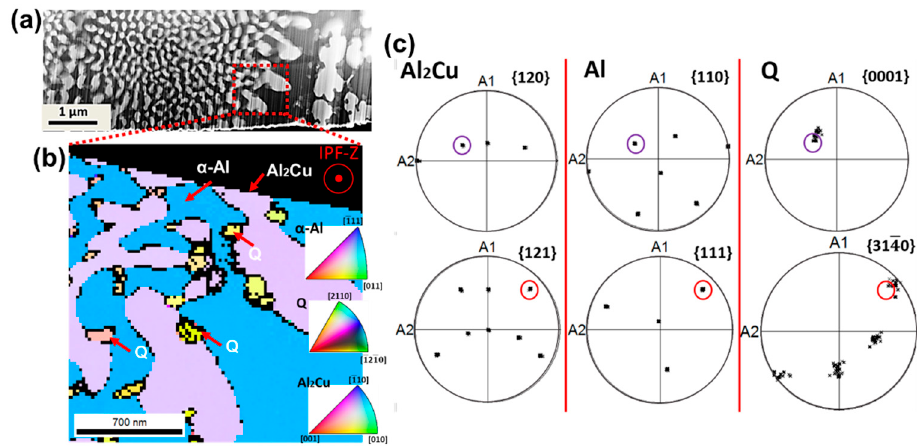
Figure 8. ( a ) SEM image showing the FIB-milled lamella ( b ) IPF-Z map of α -Al, Al 2 Cu and Q phases at cell boundary ( c ) pole figures for identification of the orientation relationship between the three phases including α -Al, Al 2 Cu and Q.